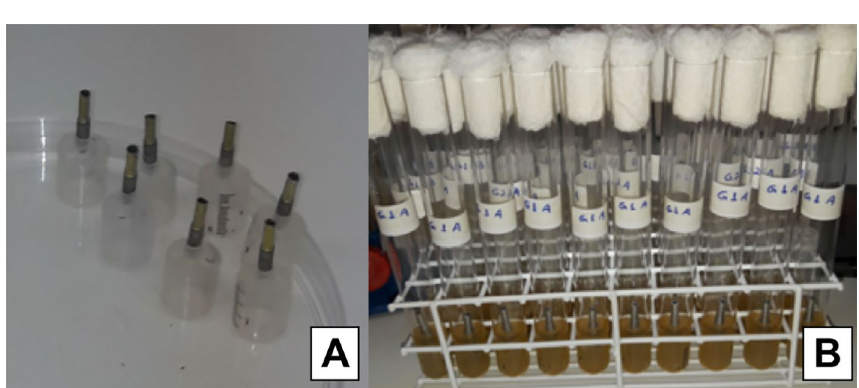
Figure 4. ( A ) Sets of implants and abutments mounted to the syringes; ( B ) Syringes with the implant-abutment specimens inserted with bacterial culture medium in the test